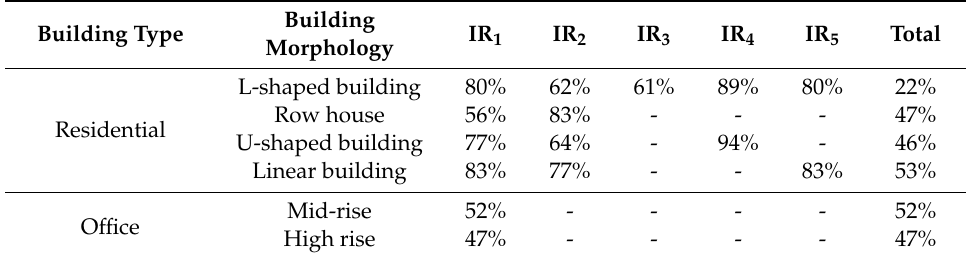
Table 9. Calculated reduction factors for the analyzed building morphologies considering all of the surfaces (roofs and façades) of the building envelope.